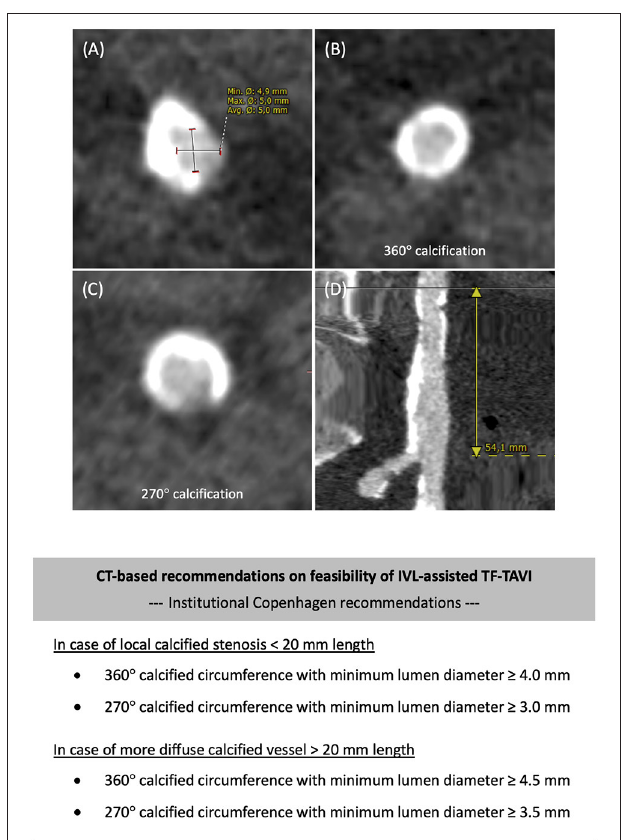
FIGURE 2 | Preprocedural CT analysis. Preprocedural computed tomography (CT) angiography analysis of the iliofemoral access. Standard assessments include: (A) Maximal and minimal diameter measured at the minimal luminal diameter (MLD) of the vessel. (B,C) Circumference of calcification: 360 ◦ or horseshoe-like (270 ◦ ) calcification. (D) Total length of the vessel calcification(s). Copenhagen recommendations on feasibility of IVL-assisted TF-TAVI based on CT angiography analysis. IVL, intravascular lithotripsy; TAVI, transcatheter aortic valve implantation; TF,